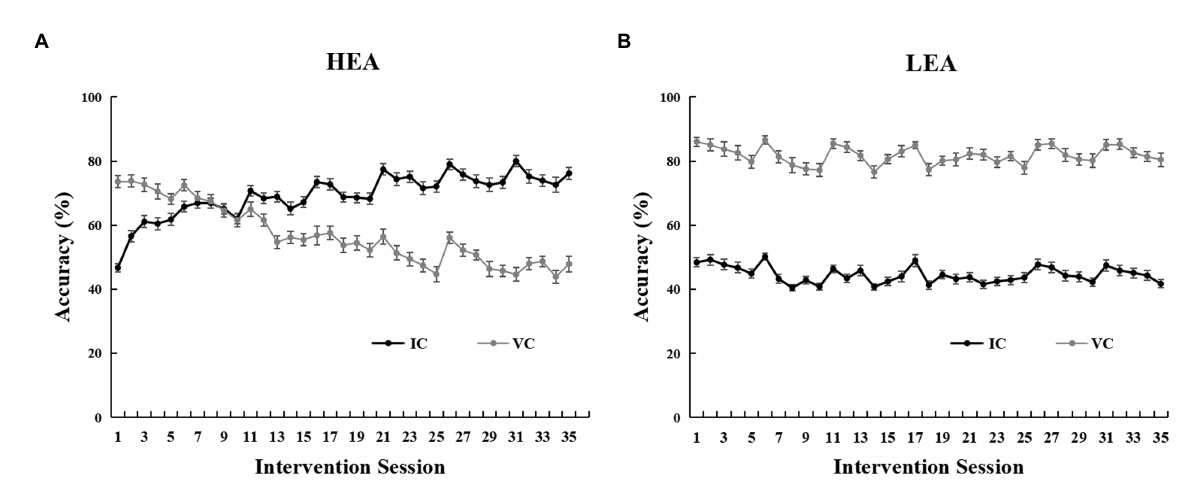
FIGURE 2 Intervention performance for the high executive attention (HEA) group (A) , and the low executive attention (LEA) group (B) , on the Posner cueing paradigm across intervention sessions. Error bars denote standard errors of the mean ( SEM ).